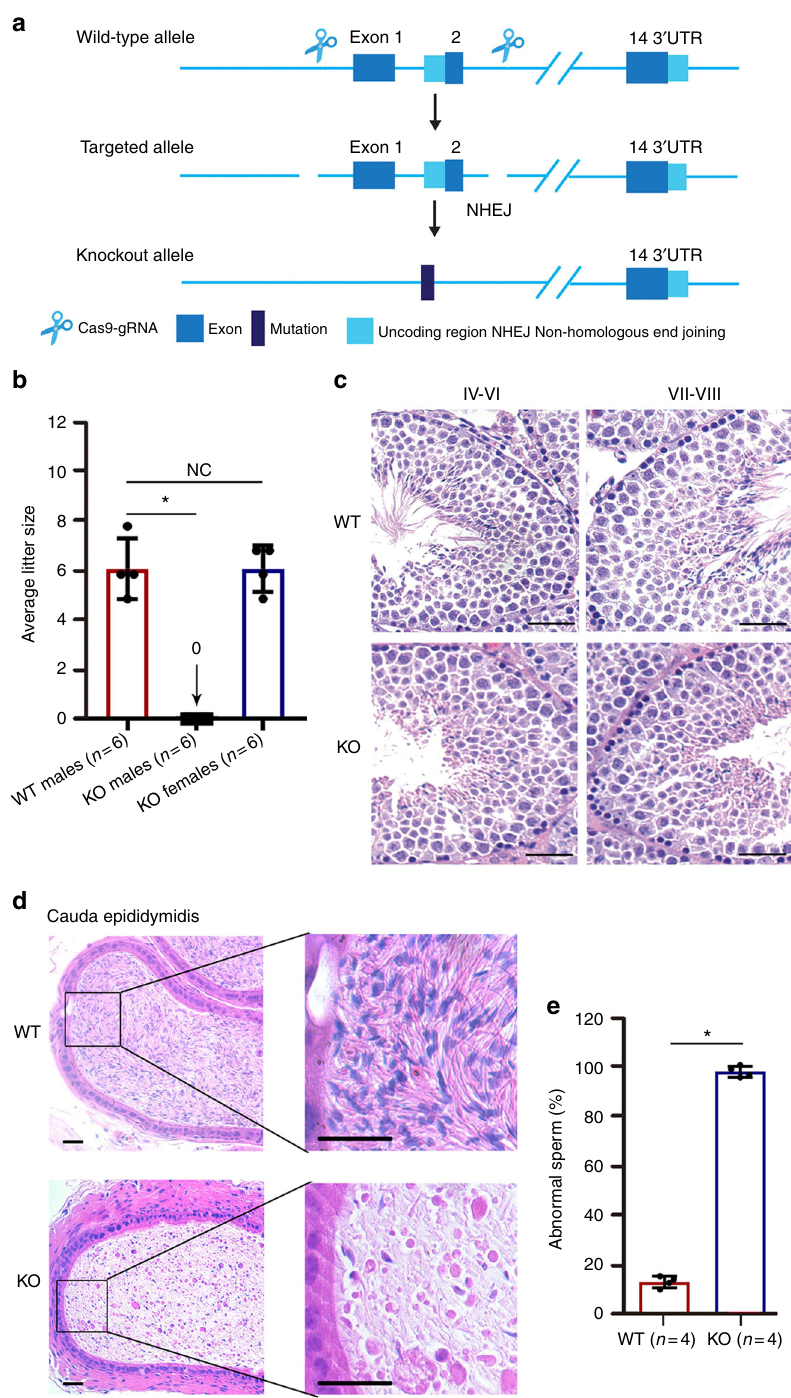
Fig. 3 De fi ciency of Qrich2 leads to MMAF in mice. a The schematic illustration of the targeting strategy for generating Qrich2 -knockout mice. A frameshift mutation was generated by deleting exon 1 and exon 2 of Qrich2 . b Fertility of wild-type (WT), knock out (KO) males and knock out (KO) females. KO male mice and KO female mice were bred with the WT mice and the average litter size was measured. KO males were completely sterile. (Student ’ s t -test; * p < 0.05; NS, not signi fi cant; error bars, s.e.m) c The development of sperm fl agella in stages IV-VIII of spermatogenesis in mice testes by H&E staining (scale bars, 20 µ m). Lack of elongated fl agella was observed in the spermatozoa of the KO mice compared with the WT mice. d The dysplasia of the sperm fl agella and decreased sperm quantity were observed in the cauda epididymidis of the KO mice (scale bars, 10 µ m). e The number of abnormal sperm in WT males and KO males. Almost 100% of sperm in KO males displayed abnormal fl agella. (Student ’ s t -test; * p < 0.05; error bars,